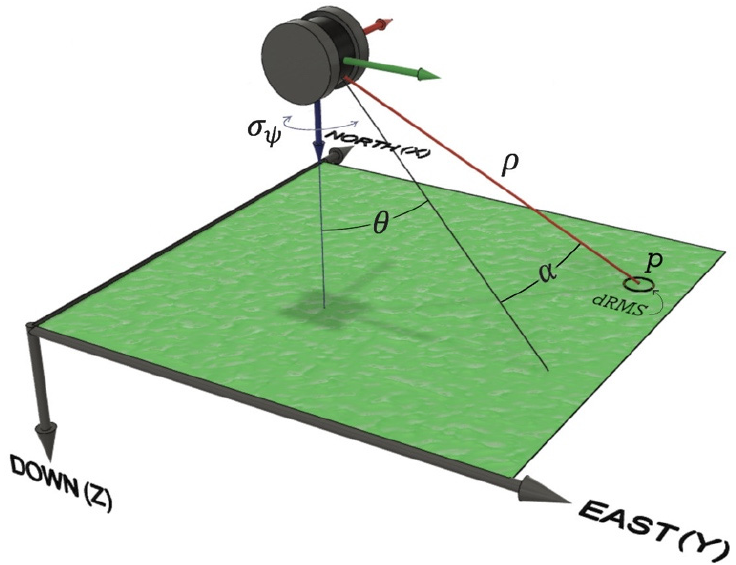
Figure 5. A local level (north–east–down) frame illustrating an observed ground point, the lidar observations, the heading precision, and the horizontal precision of the ground point.